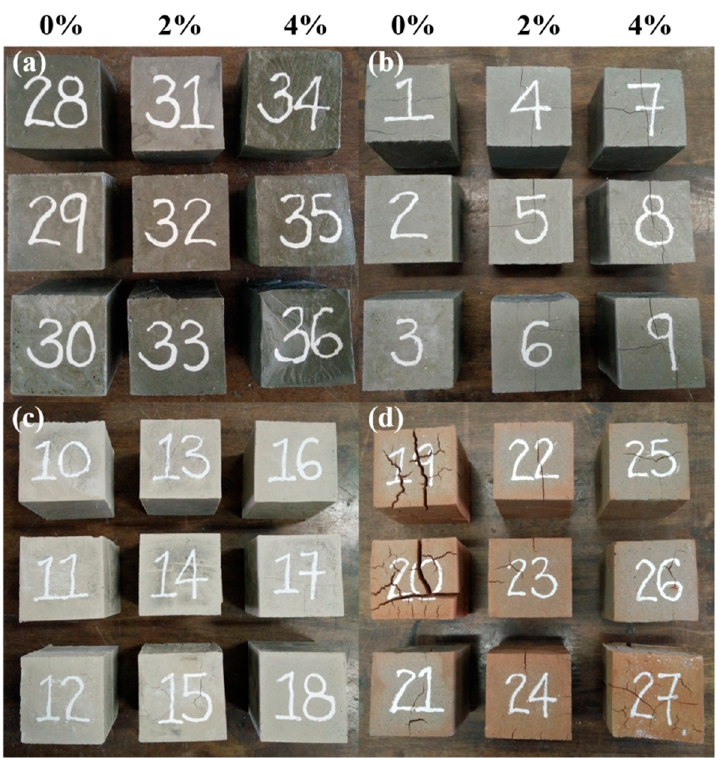
Figure 3. Physical appearance of fly ash geopolymers with varying silica fume content: ( a ) unexposed; ( b ) 200 °C; ( c ) 600 °C; and ( d )1000 °C.